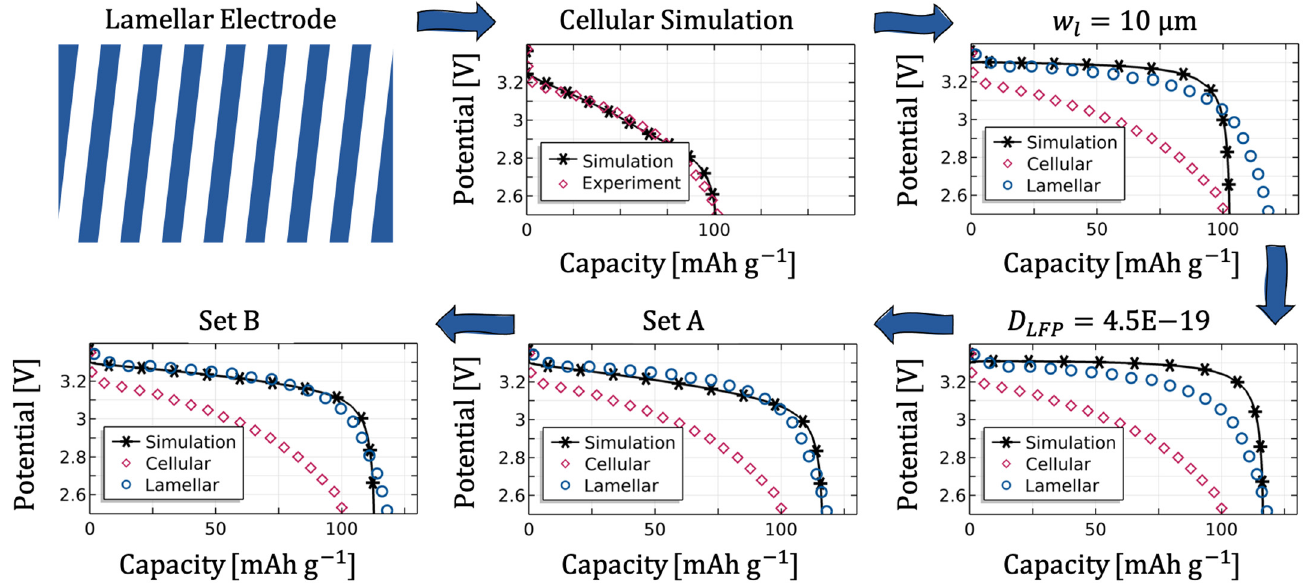
Table 4. Set of parameters for sets A and B in Figure 19.